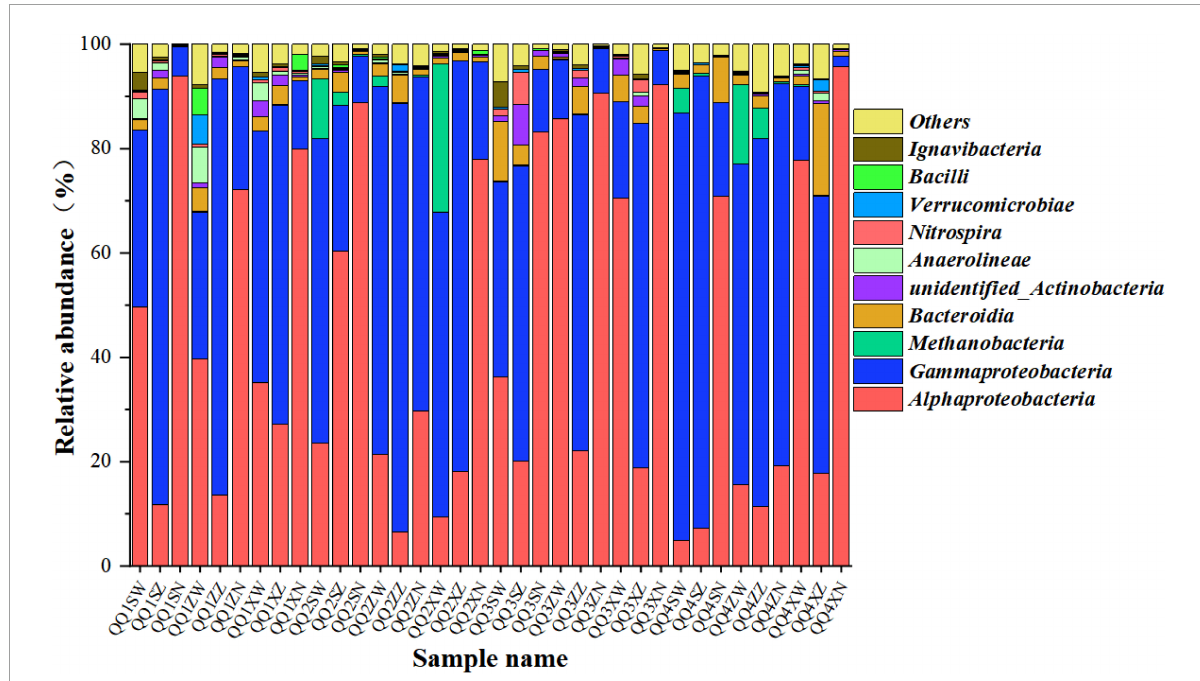
FIGURE5 A class-level relative abundance of top 10 dominant bacteria of pyrosequences from biofilm samples taken in the H 2 -based MBfR under the four phases operating with H 2 supplying pressure, where “H1,” “H2,” “H3,” and “H4” represent H 2 pressures of 0.04, 0.06, 0.08, and 0.1, respectively; “U,” “M,” and “D” (the third letter of the sample name) represent the samples were obtained from the locations of upper, middle, and lower portions of the hollow fiber membranes (HFMs), and “O,” “D,” and “I” (the fourth letter of the sample name) denote the outer, middle, and inner layers of each location of the HFMs. The same labeling is used in Figure 6